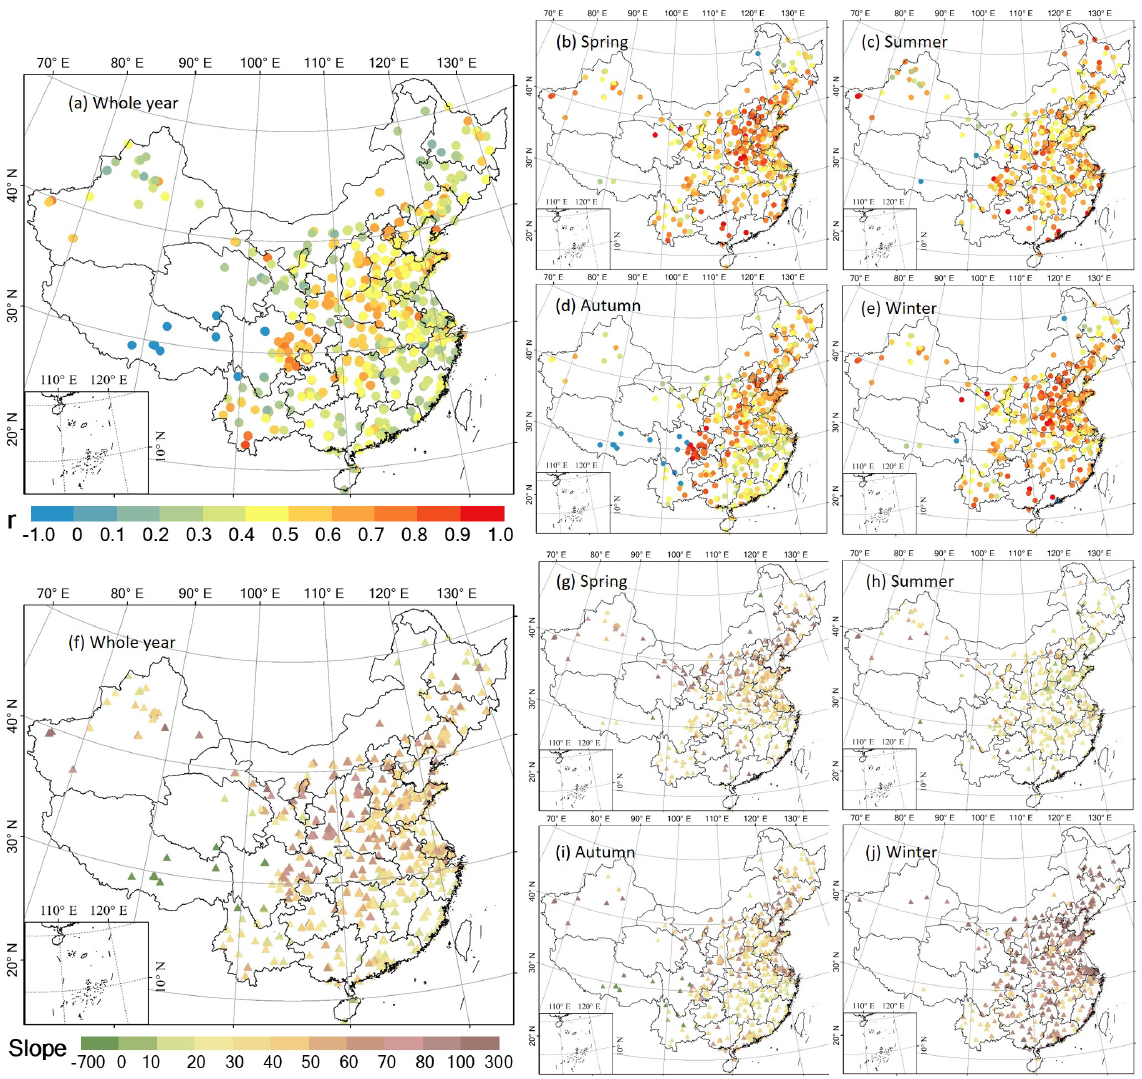
Figure 4. Spatial distributions of the relationship between ambient PM 2 . 5 and satellite AOD pairs over China in 2019. Panel (a) shows the correlation coefficient for the whole year, and panels (b) – (e) show the correlation coefficients for each respective season. Panels (f) – (j) are based on the slope values of the linear regression model. Please note that only statistically significant results, i.e., p level < 0.05, are presented